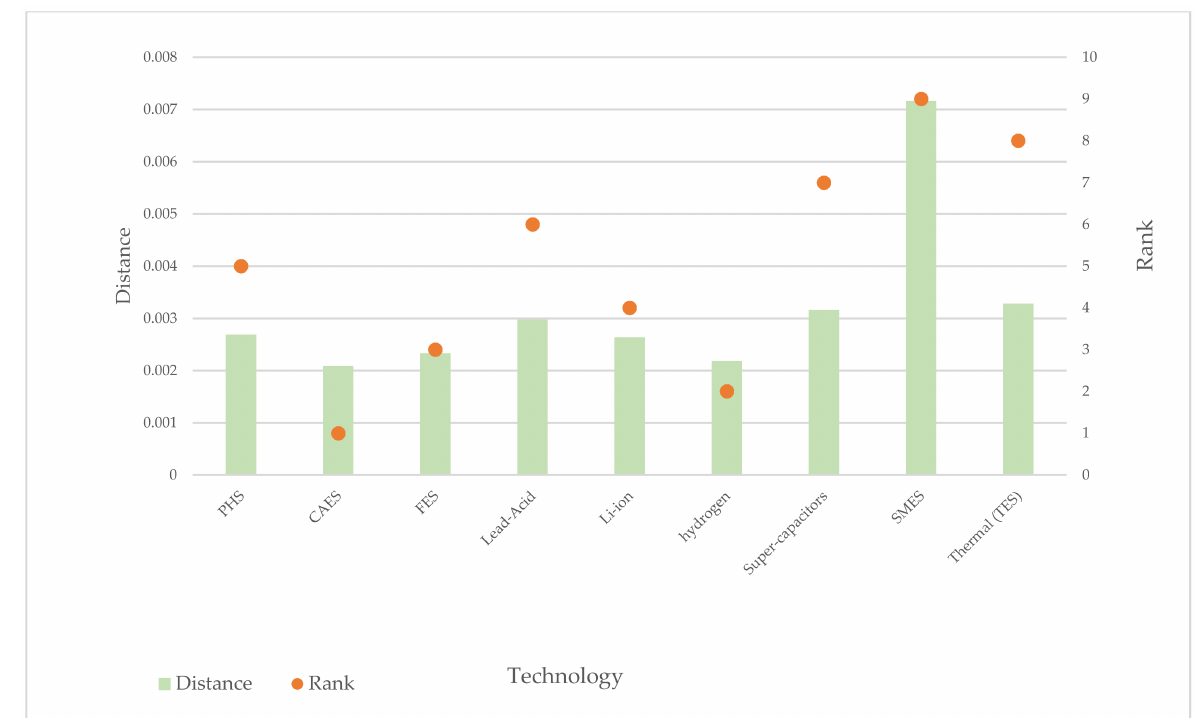
Figure 5. The distance calculation and ranking results in Scenario 1.